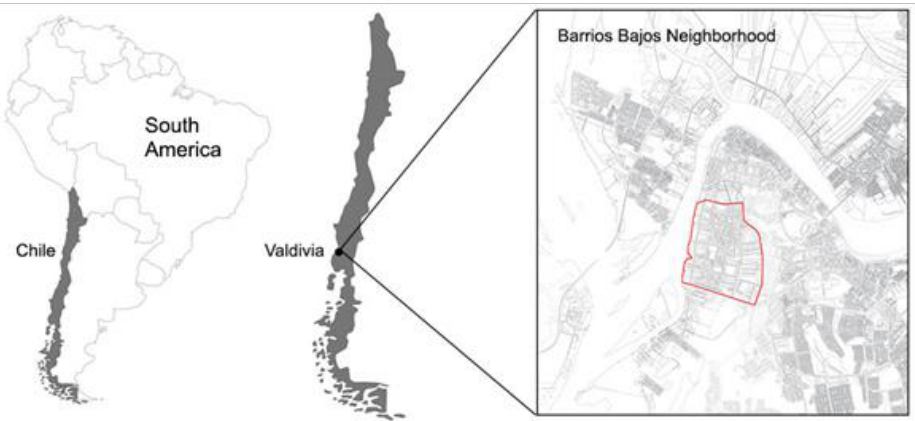
Figure 1. Barrios Bajos Neighbourhood location in the city of Valdivia. Source: Authors.